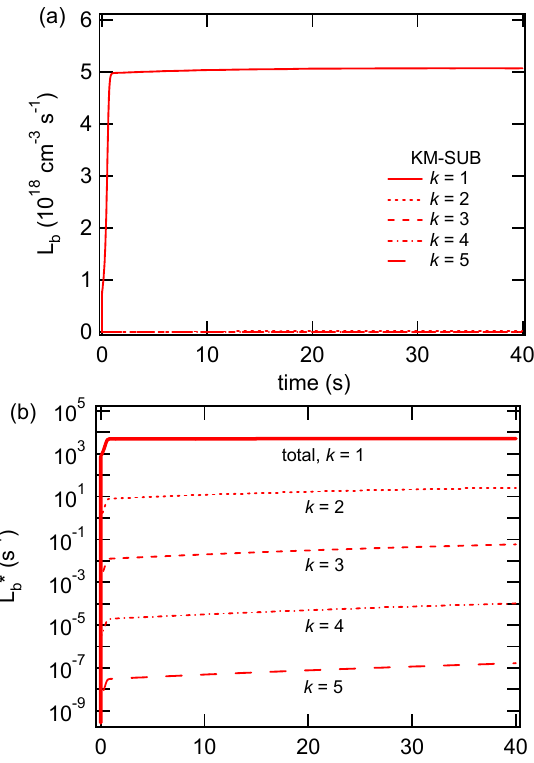
typical polluted air with 100 ppb O 3 , t 1 / 2 was shortened to ) of oleic ∼ 8 min for r = 0 . 2 µm and ∼ 40 min for r b k p ) b